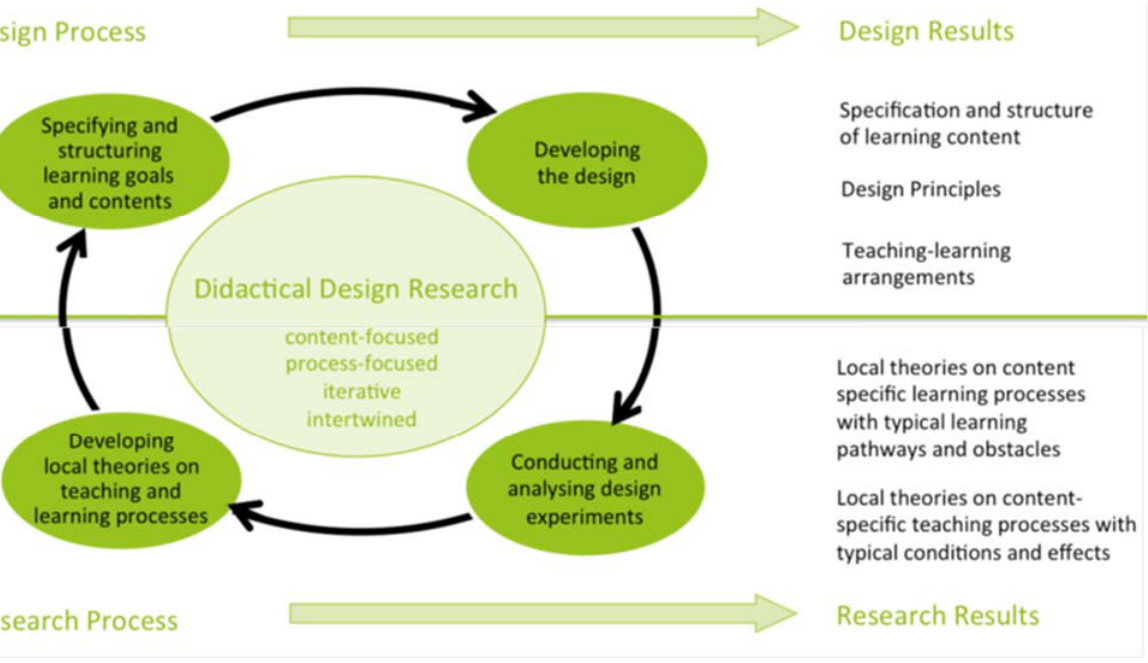
Figure 1. Research Group: “FUNKEN”—working areas in content ‐ specific didactical design (Hußmann and Prediger 2016, p. 35.) mann and Prediger 2016, p.